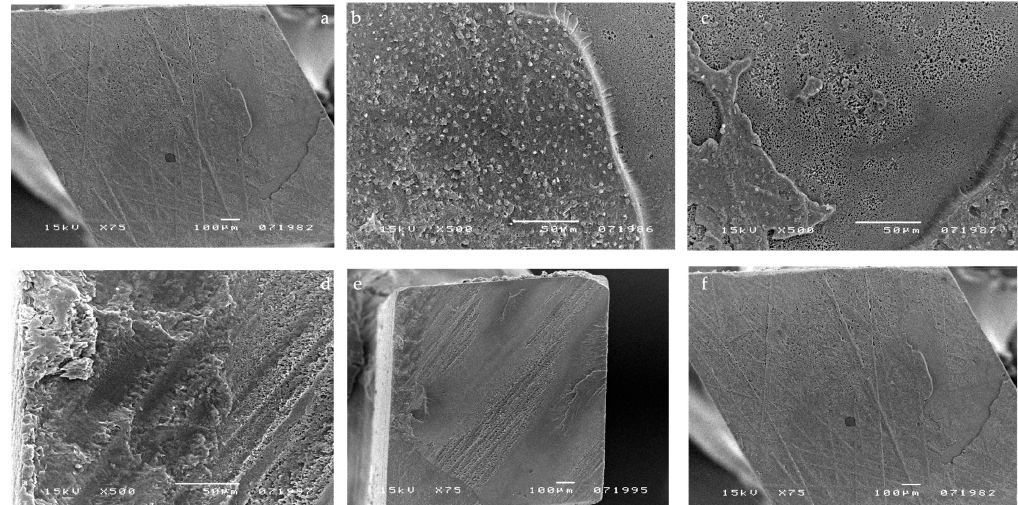
Figure 4. SEM micrographs illustrating fractured surfaces for samples bonded with Scotchbond 1 XT. Some resin tags were seen in the ( a , b ) micrographs when DBA was applied without pulpal pressure (0 cm H 2 O). ( c , d ) Micrographs show a representative sample of Scotchbond 1 applied simultaneously to pulpal pressure (20 cm H 2 O). A mixture of both small and large droplets (from 0.5 to 20 μ m) was observed, which had sometimes coalesced to larger droplets. ( e , f ) Micrographs show a representative sample of Scotchbond 1 XT applied and cured before the application of pulpal pressure (20 cm H 2 O). A cohesive fracture and no droplets were present.